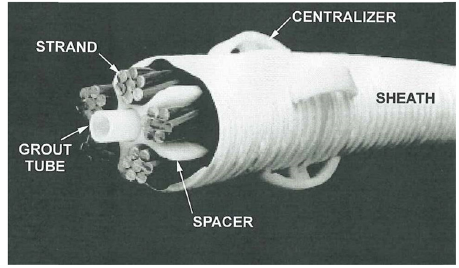
Figure 3: Grouted ground anchor section.